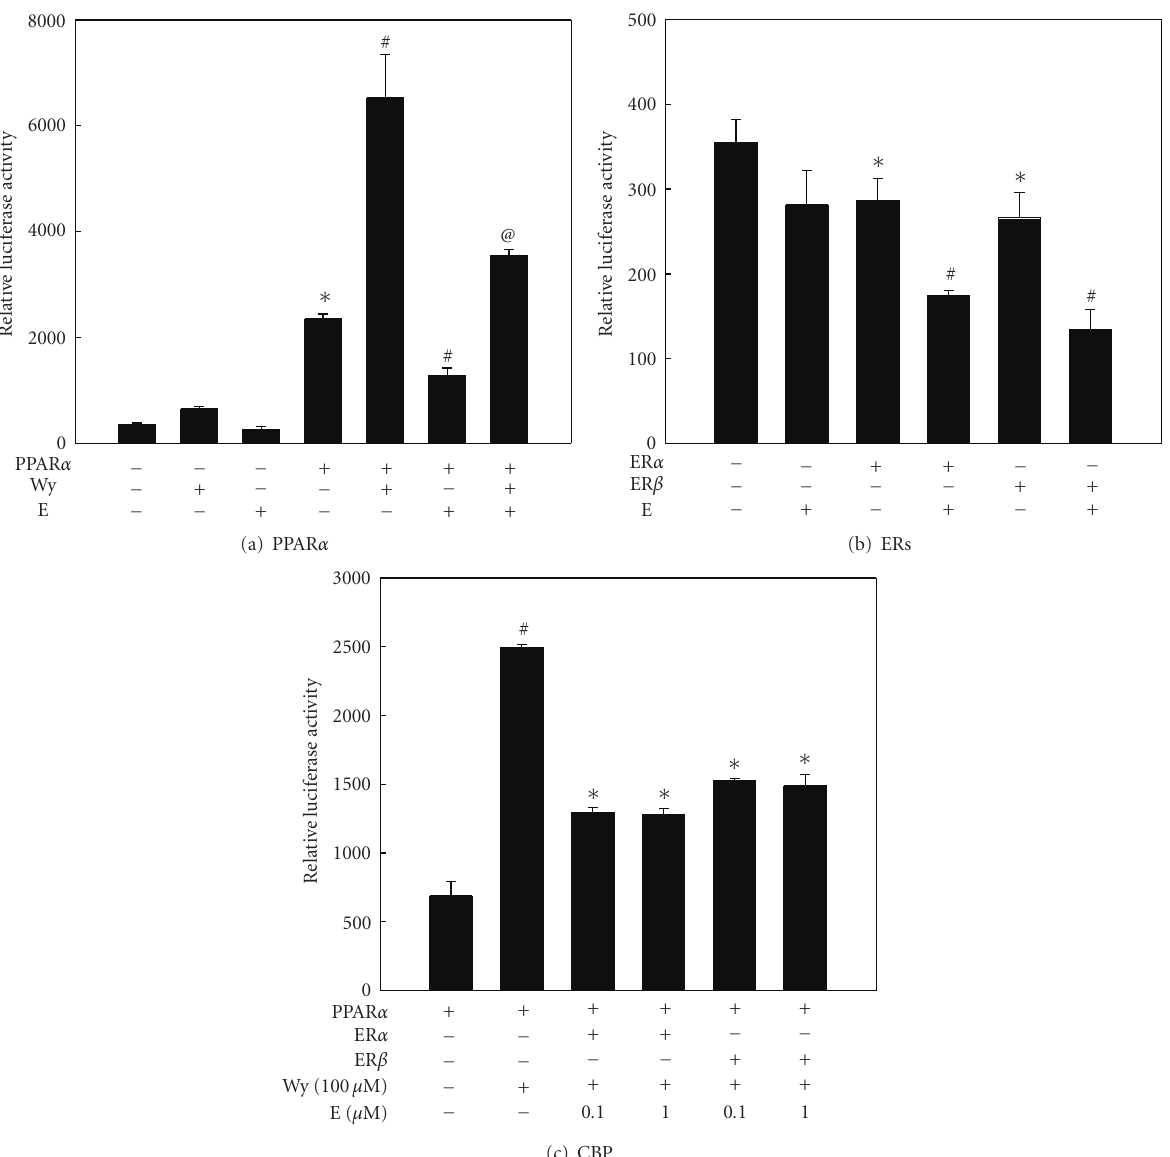
Figure 6: Inhibition of PPAR α reporter gene expression ((a) and (b)) and coactivator recruitment (c) by 17 β -estradiol. (a) NMu2Li cells were transiently transfected with expression plasmids for PPAR α and PPRE 3 -TK-Luc reporter. ∗ Significantly di ff erent versus control group, P < . 0001 . # : Significantly di ff erent versus PPAR α group P < . 0001 . @ Significantly di ff erent versus PPAR α /Wy group, P < . 001 . (b) NMu2Li cells were transiently transfected with expression plasmids for PPRE 3 -TK-Luc reporter and ER α or ER β. ∗ : Significantly di ff erent versus control group, P < . 05 . # : Significantly di ff erent versus respective ER group, P < . 01 . (c) CV-1 cells were transiently transfected with expression plasmids for VP16-mPPAR α , GAL-CBP, reporter plasmid pFR-Luc, and VP16-hER α or VP16-hER β. #: Significantly di ff erent versus PPAR α group, P < . 01 . ∗ : Significantly di ff erent versus PPAR α /Wy group, P < . 005 . Adapted from [32].